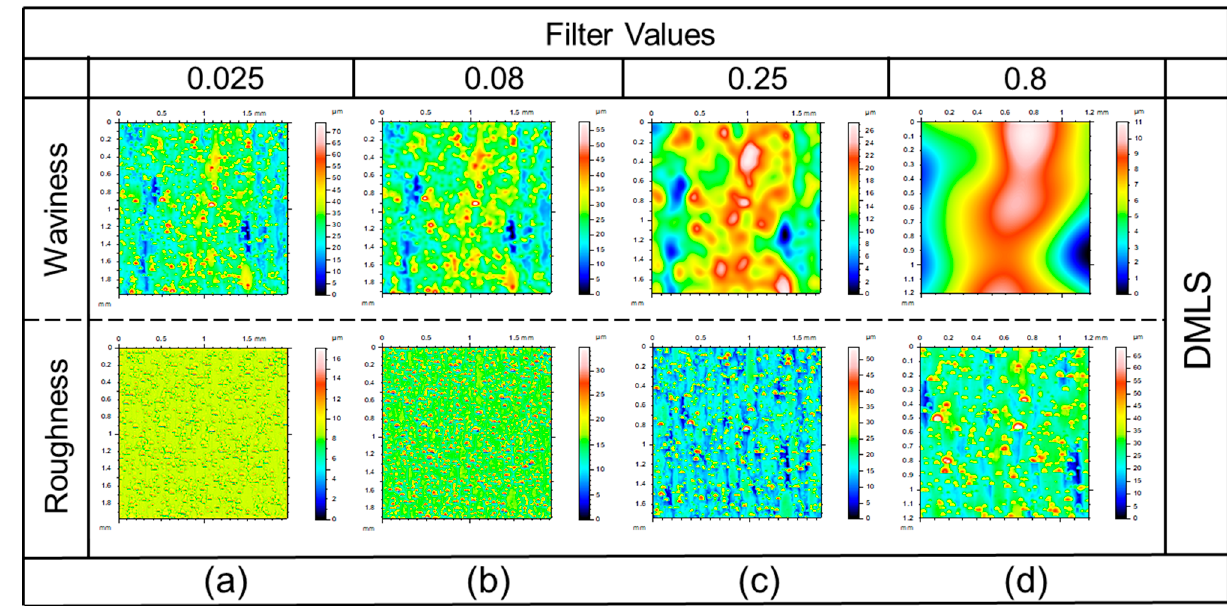
Figure 9. Surface topography of as-built DMLS surface after filtering.